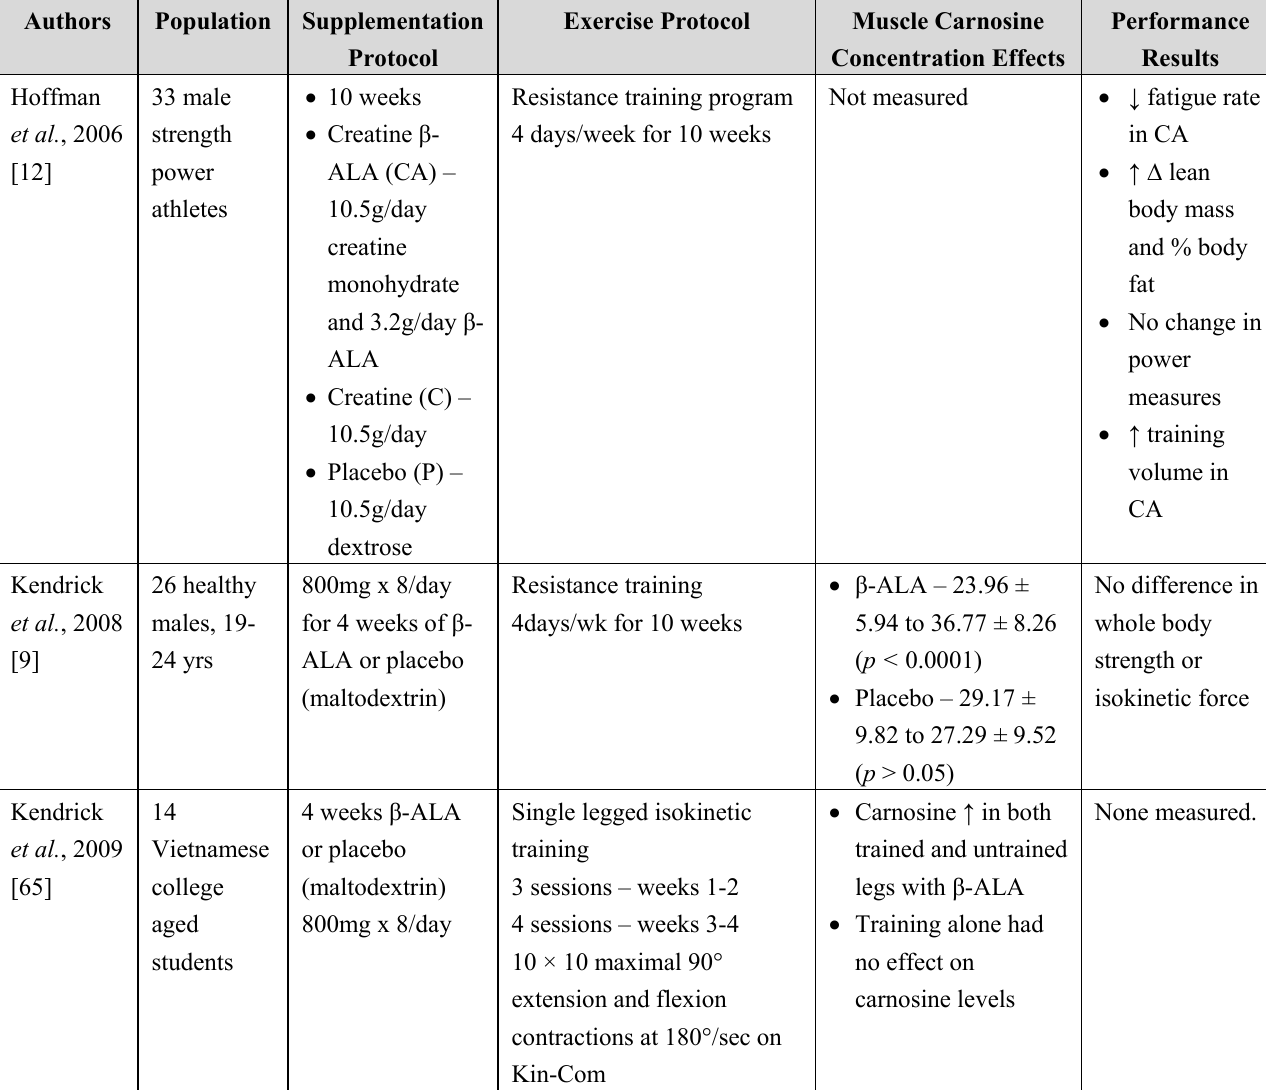
Table 3. Summary of recent β -ALA supplementation and exercise training